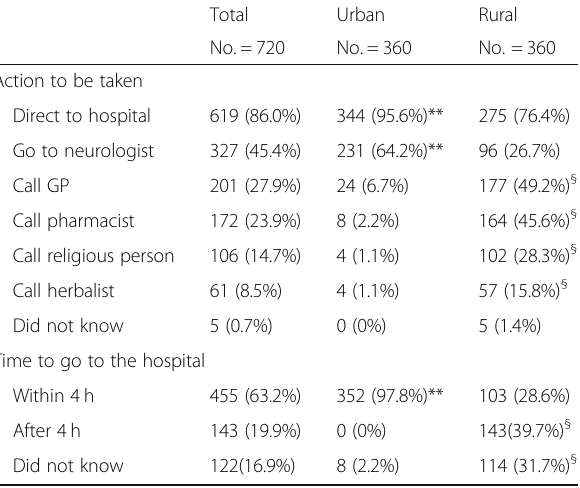
Table 5 Knowledge of the action to be taken and the